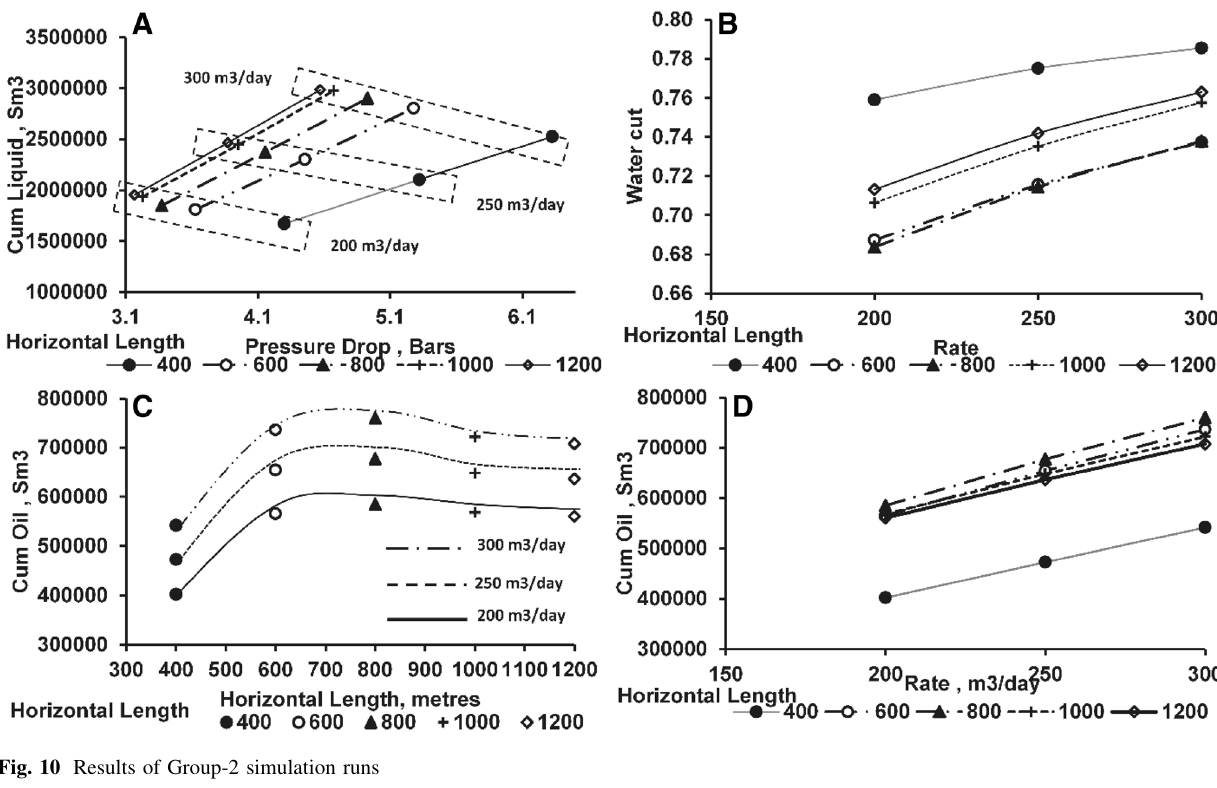
Fig. 10 Results of Group-2 simulation runs